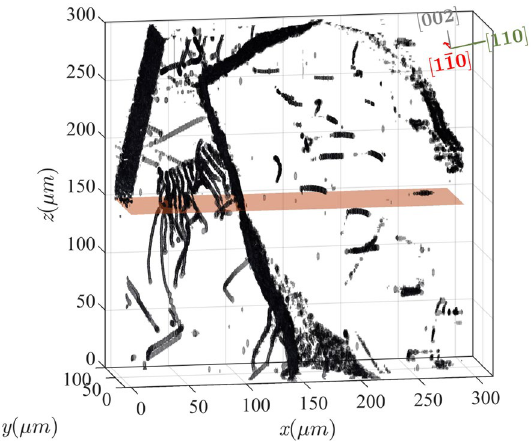
3 Figure 3. 3D map of dislocation structures over a 100 × 300 × 300 µ m volume. All dislocation features are shown by the grayscale surfaces, with the crystallographic coordinate axes inserted in the top right of the plot. Each 3 voxel in the map is 125 × 45 × 1000 nm . The orange plane represents the 2D slice shown in Fig. 2. Note that the χ position of the scan shown in Fig. 2 is 0.02 ◦ different than Fig. 3. The figure is made using the MATLAB code in the link https:// github. com/ leora dm/ Dislo catio n3DAn alysis. git.